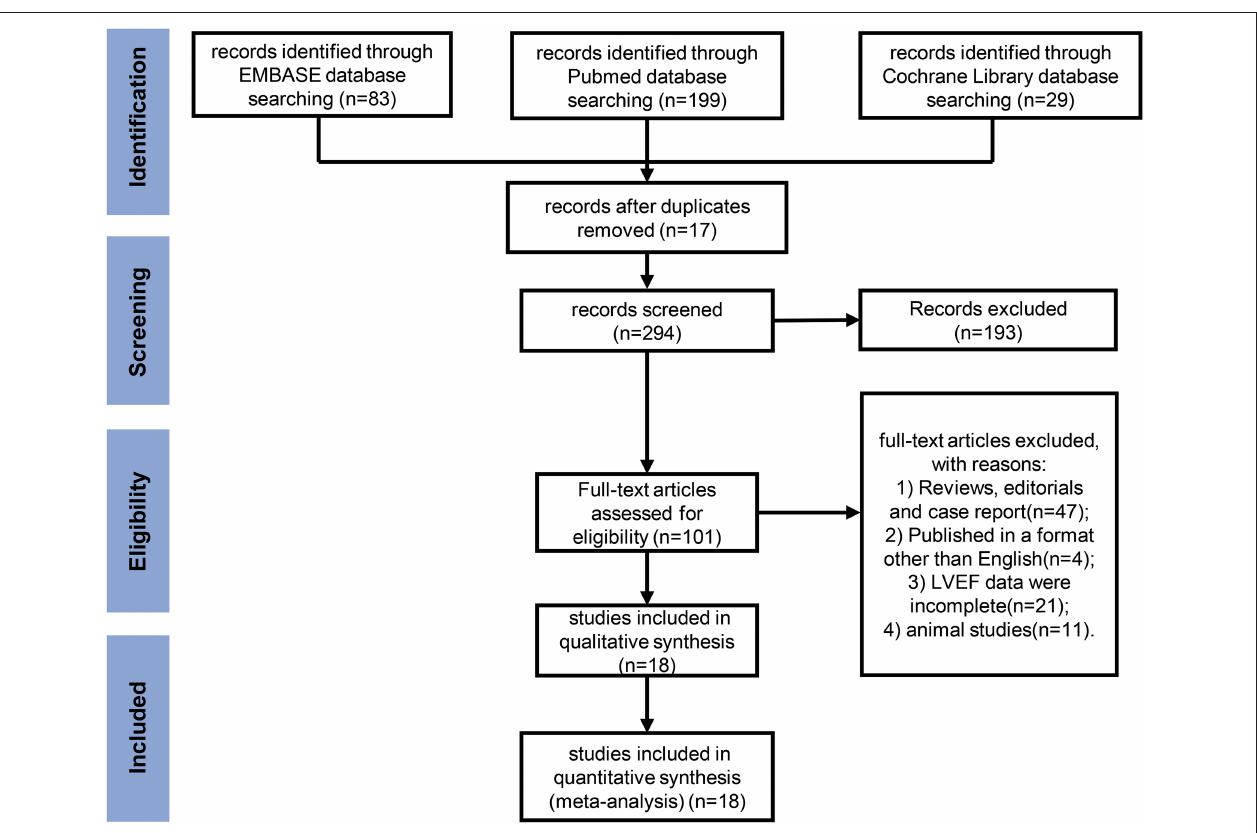
FIGURE 1 | Preferred Reporting Items for Systematic Reviews and Meta-Analyses (PRISMA) flow diagram for meta-analysis. A flow diagram of the studies screened, assessed for eligibility, and included in the review, with reasons for